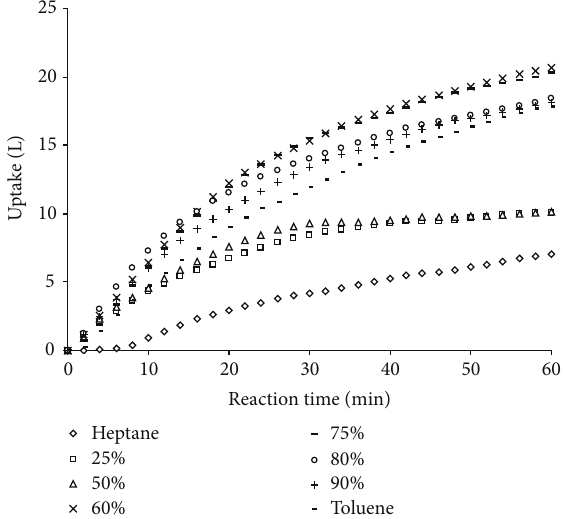
Figure 4: Profiles of ethylene uptake in Litres of ethylene versus minutes of reaction during polymerization experiments as regis- tered by the Gas Control